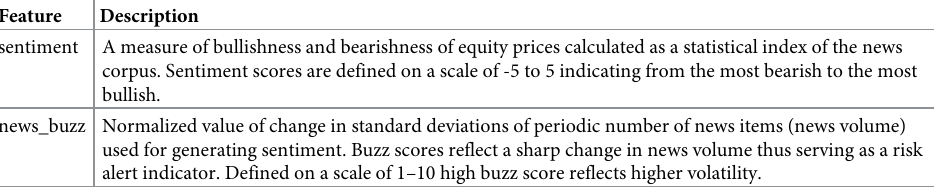
Table 1. Feature selection of FinSentS